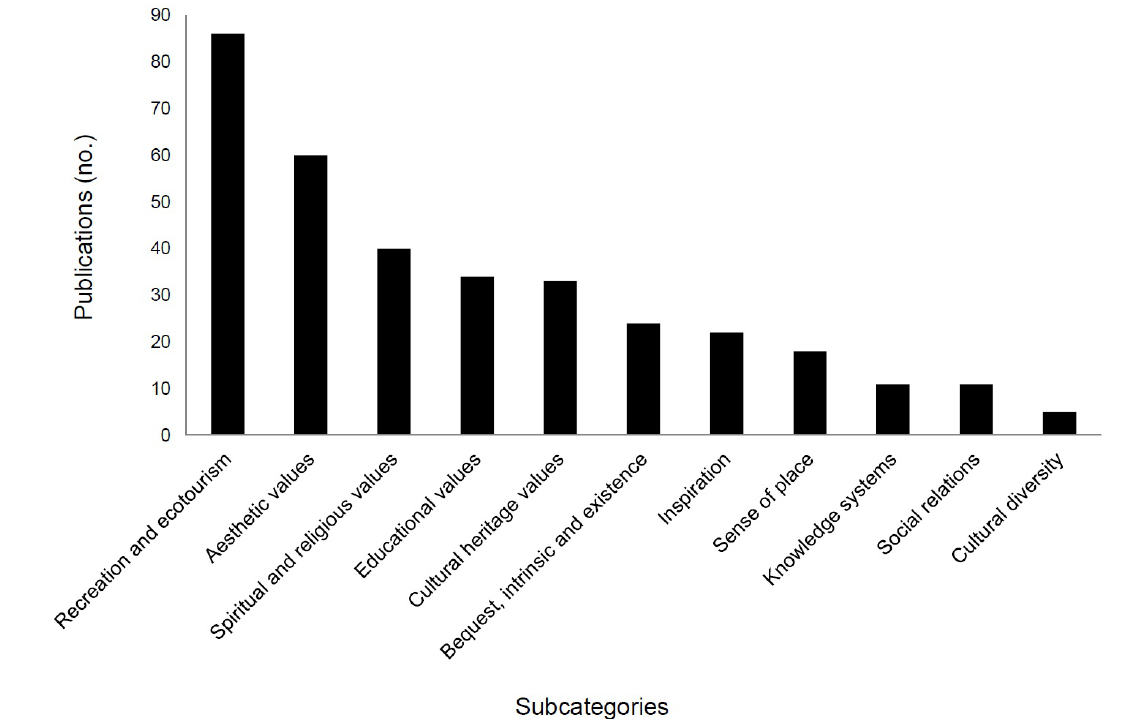
Fig. 3 . Number of publications investigating different subcategories of cultural ecosystem services. Publications could have no entries or multiple entries if, respectively, no or multiple subcategories were addressed.